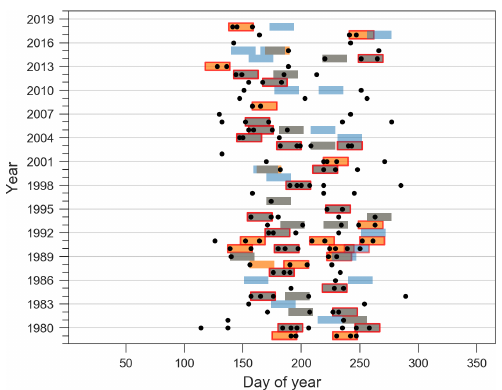
Figure A3. Catchment 4060660750 located in central China, preva- lent clustering ( S cl = 43 . 23) and a limited degree of similarity be- tween the classifications Cl n and Cl acc : S cont = 0 . 59. A total of 35 episodes contain two or more extreme events ( n w > = 2). Extreme events and episodes are shown as in Fig.